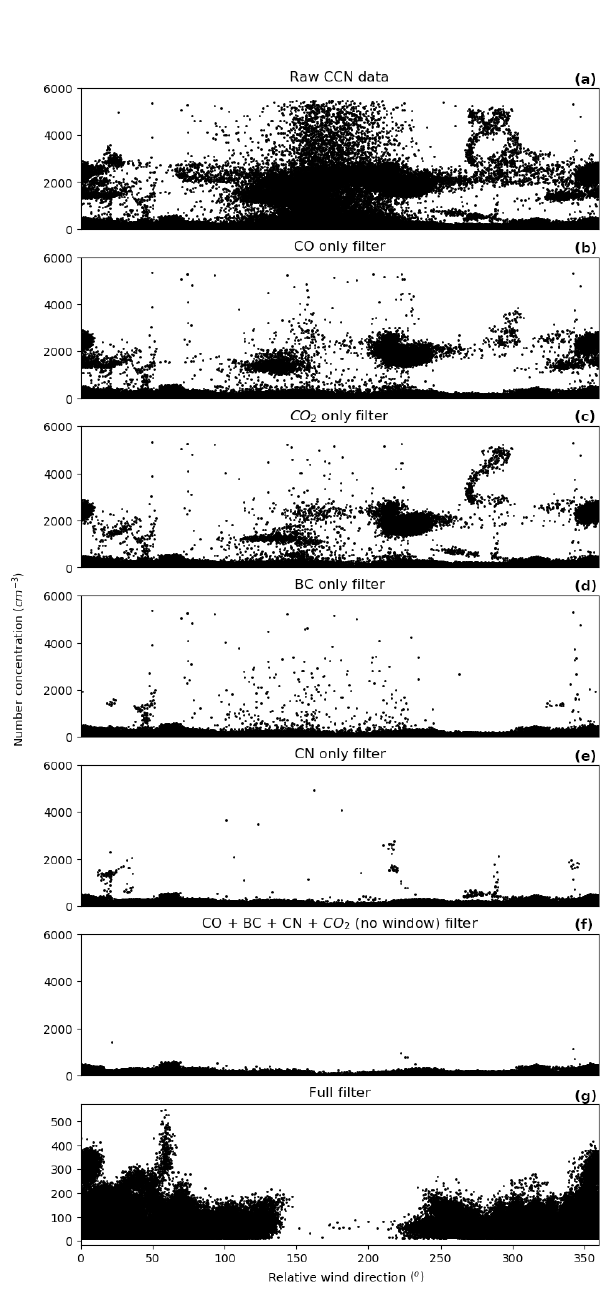
Figure 3. CCN data (linear scale) with the different steps of the al- gorithm applied separately: panel (a) shows unfiltered data, panels (b) to (e) show single-parameter filters, panel (f) shows the com- bination of the four parameters, and panel (g) shows the full filter, which includes all parameters and the application of a window re- moval. Note the change in scale of the y axis in the final panel.